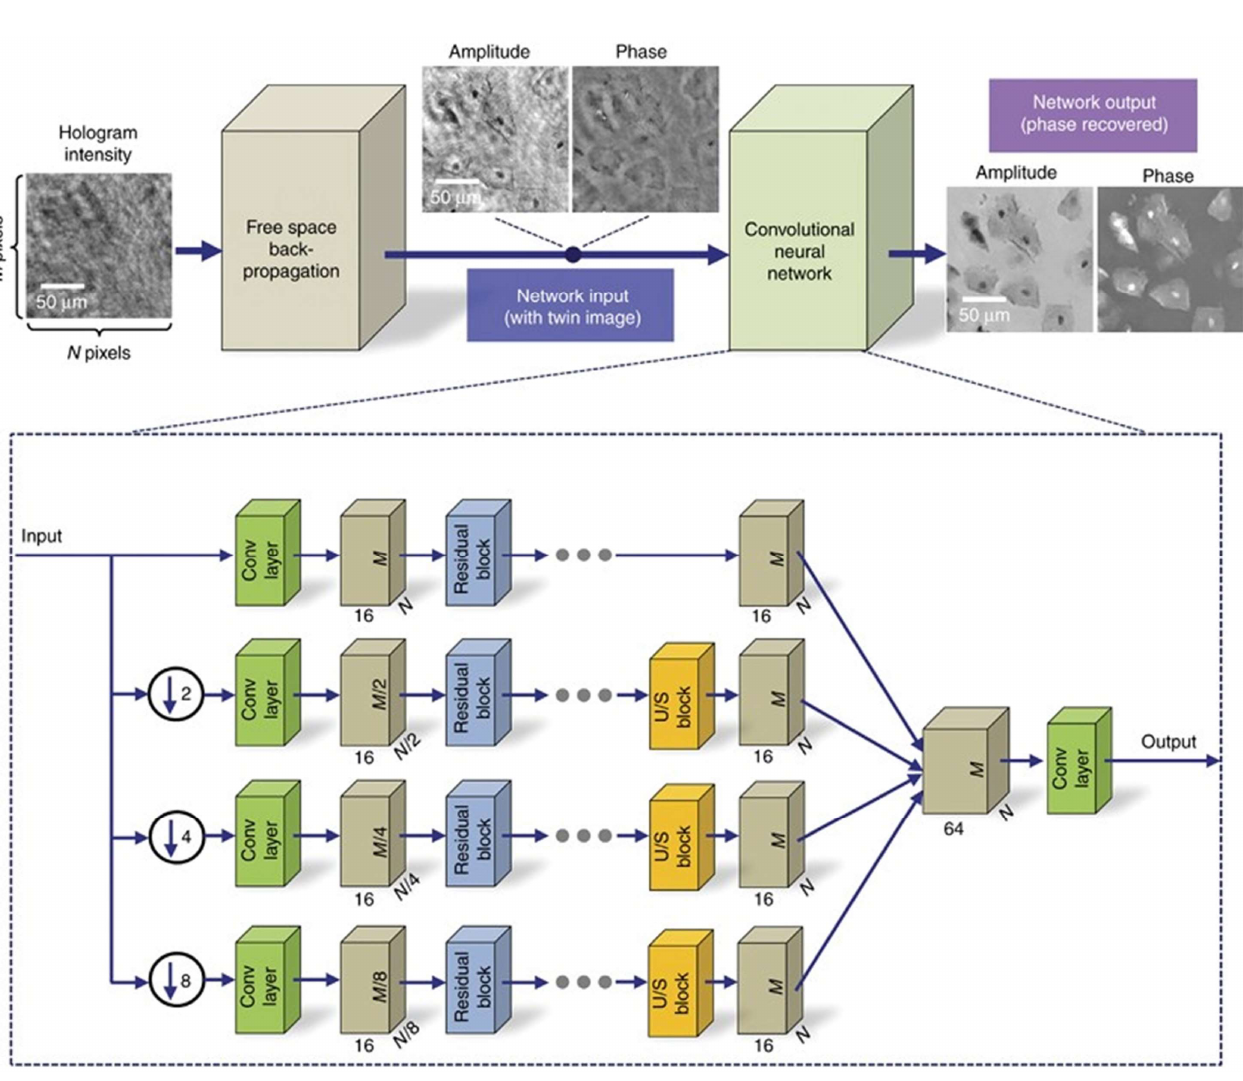
Figure 3. CNN architecture to recover complex-value information of the object